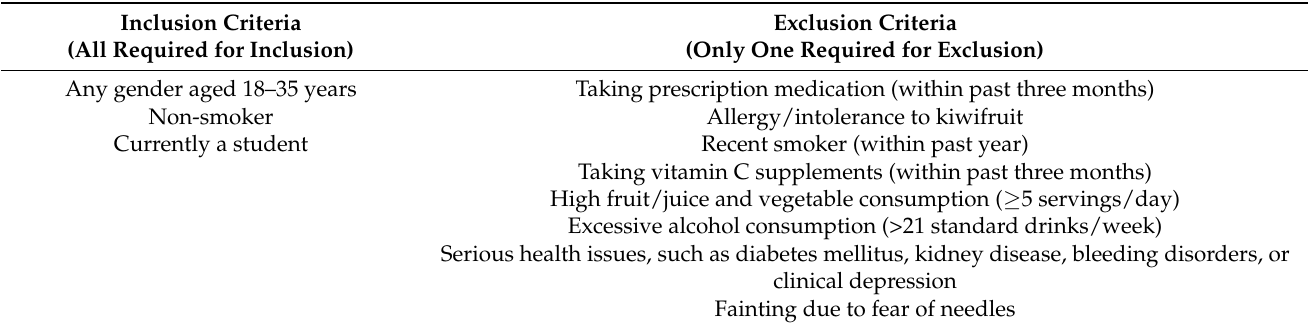
Table 1. Eligibility criteria assessed in the online screening and screening appointment. Inclusion